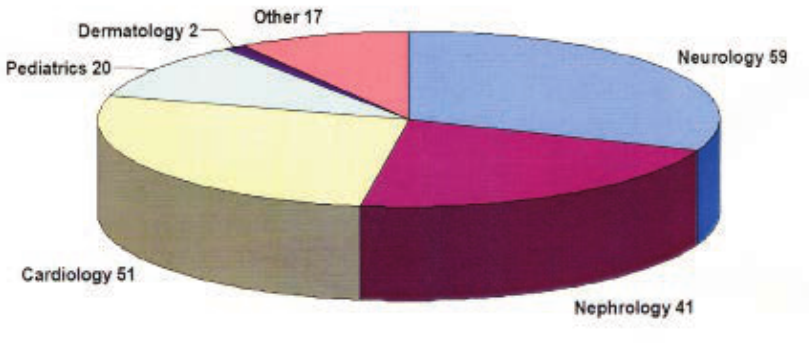
Figure 1. Distribution of patients with mutations in the GLA